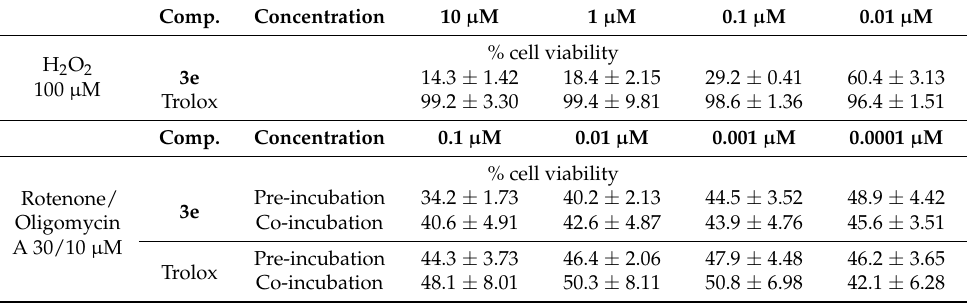
Table 5. Cells viability (%) after treatment with H 2 O 2 (100 µ M) or mixture of rotenone (30 µ M) and oligomycin A (10 µ M) at the chosen concentrations of 3e . Cells viability was determined by MTT test. Data were expressed as the mean ± SD. Experiment was done in quadruplicate and repeated three